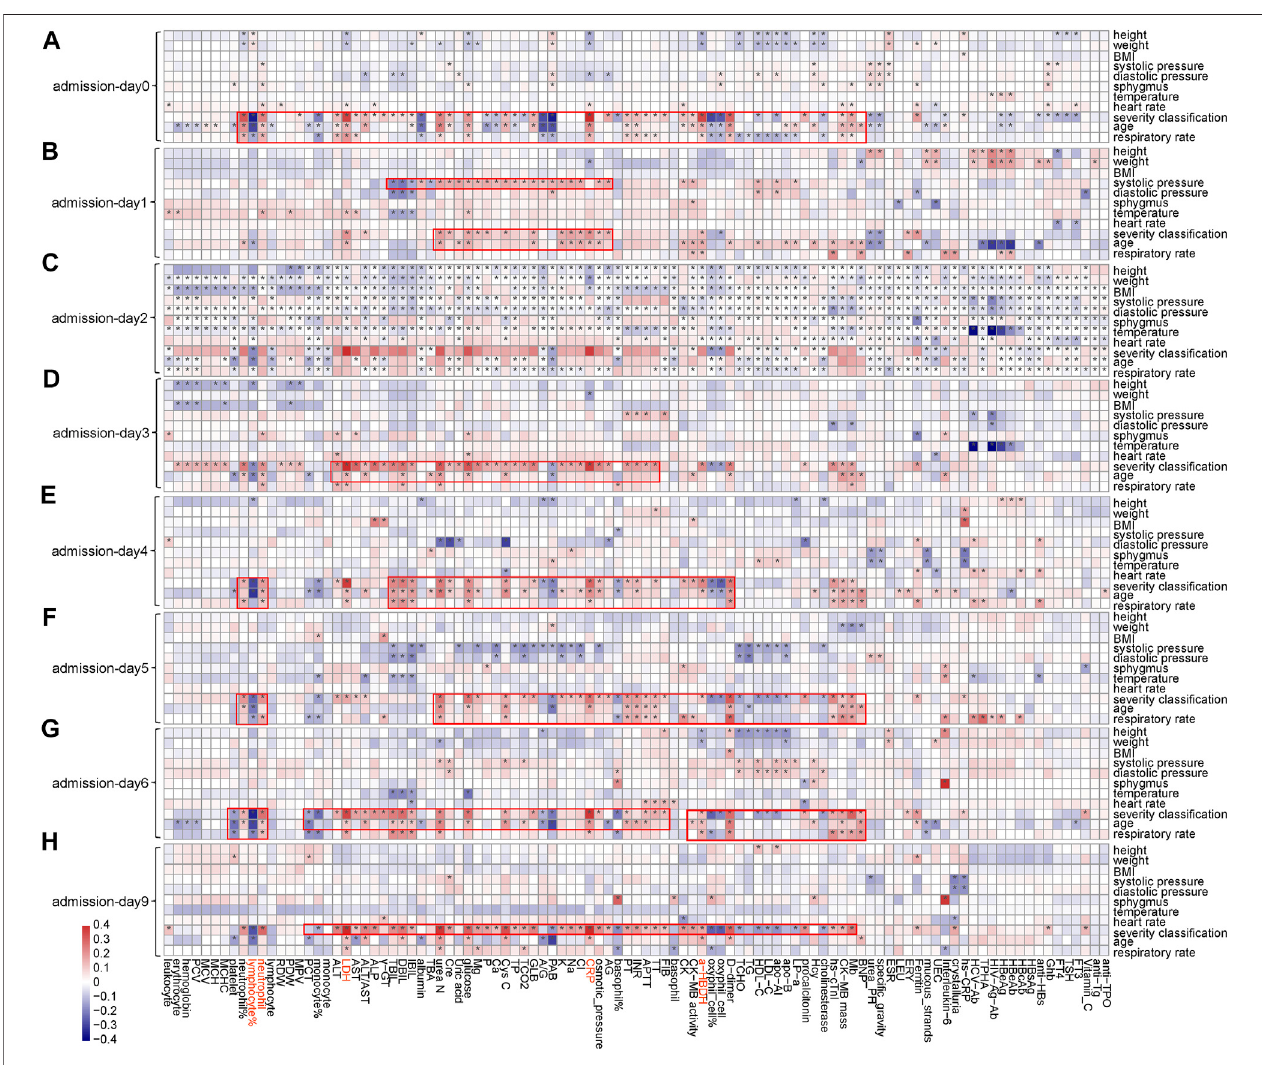
FIGURE 3 | Associations between clinical features and phenotypic characteristics based on several representative time points. (A) Based on admission day (admission-day 0). (B) Based on the third day after admission (admission-day 1). (C) Based on the sixth day after admission (admission-day 2). (D) Based on the ninth dayafteradmission(admission-day3). (E) Basedontheadmissionday(admission-day4). (F) Basedonthethirddayafteradmission(admission-day5). (G) Basedonthe sixth day after admission (admission-day 6). (H) Based on the ninth day after admission (admission-day 9). Note: *represents a signi fi cant correlation between a phenotypic characteristic and a clinical feature (Pearson correlation: p <